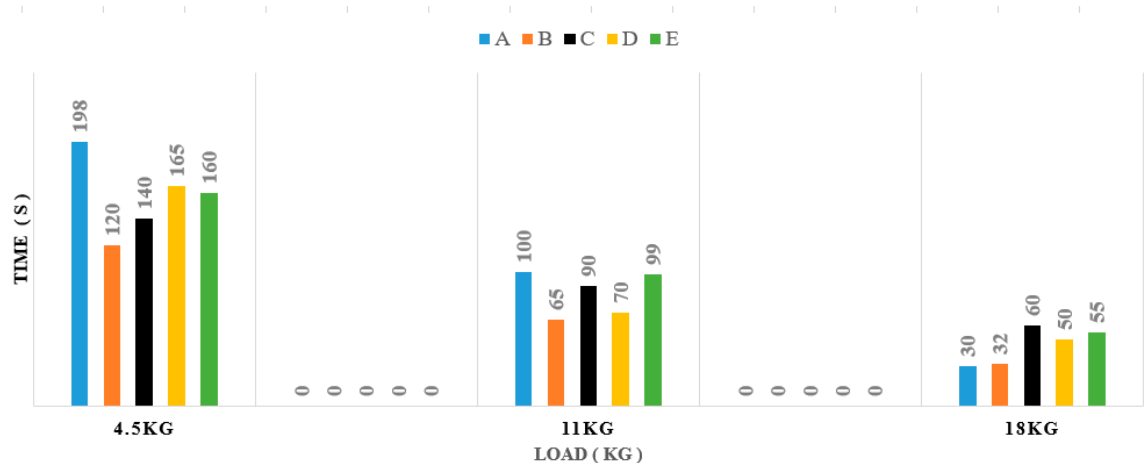
Figure 18. The distribution bar chart time of human fatigue with the load.